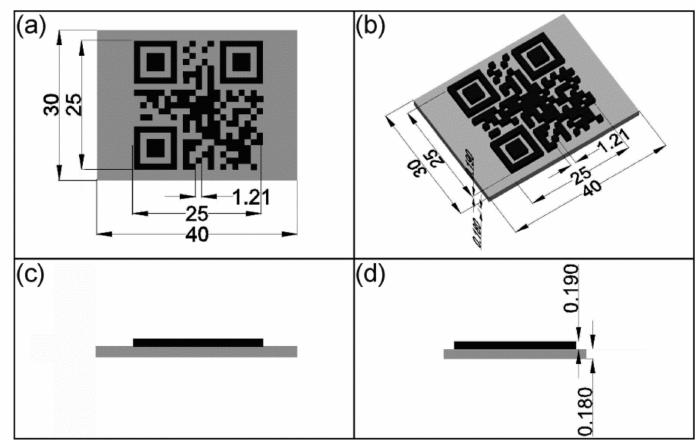
Figure 3. Technical drawing of a virtual QR code carrier including a substrate layer (gray color) and a structural QR code elevation (black color): Top view ( a ), isometric view ( b ), front view ( c ), and left view ( d ). All data are provided in